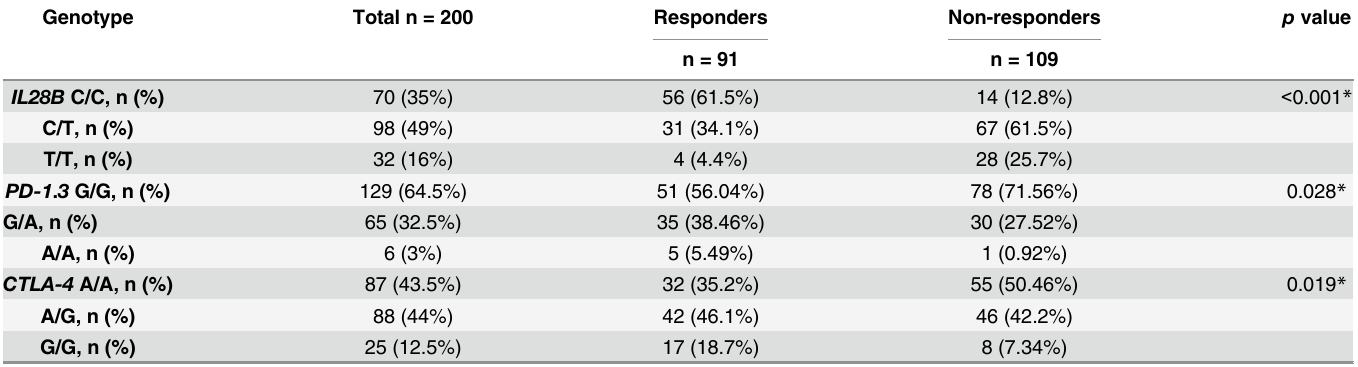
Table 2. Genotypes distribution for IL28B (rs12979680) , PD-1 . 3 (rs11568821) and CTLA-4 49A/G (rs231775) genes.